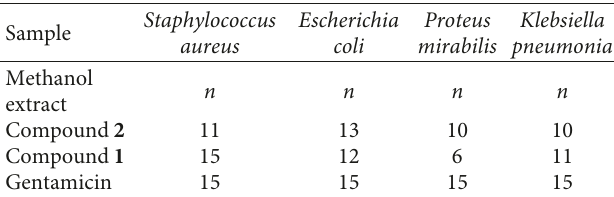
n ≤ 6 is null, and n > 6 is sensitive.